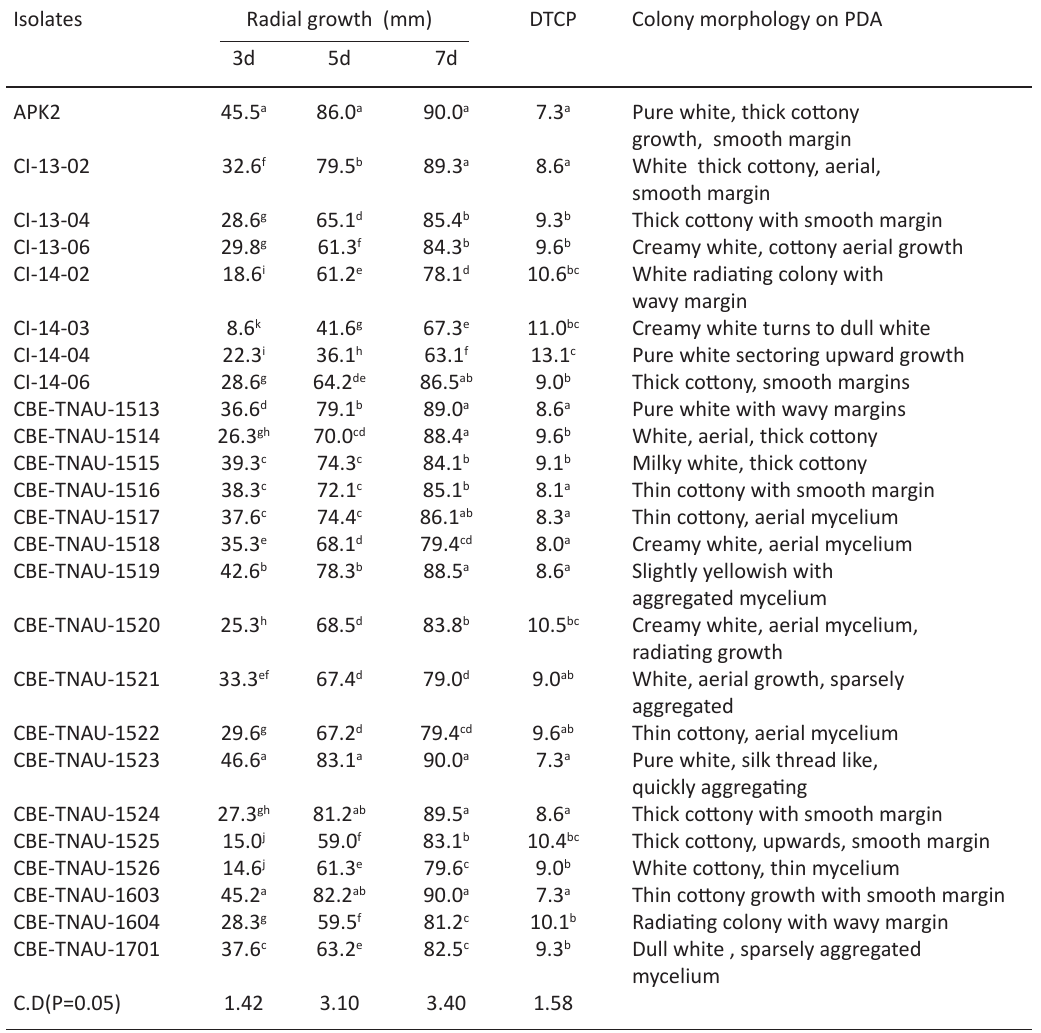
Table 1. In vitro assessment of colony morphology Isolates Radial growth (mm) DTCP Colony morphology on